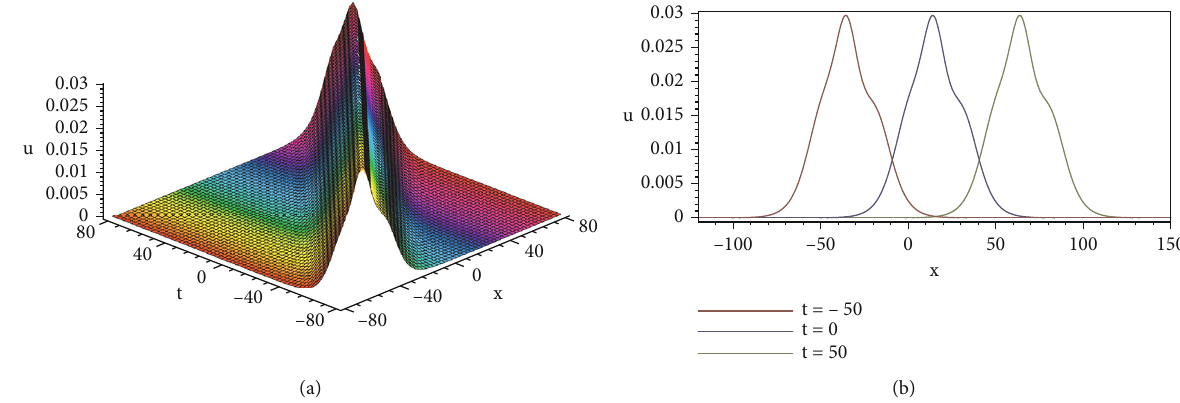
Figure 2: (a) Asymmetric soliton of the higher-order Boussinesq equation with the parameters (16). (b) The wave propagation pattern along x -axis by selecting di ff erent time t = − 50, t = 0, t = 50